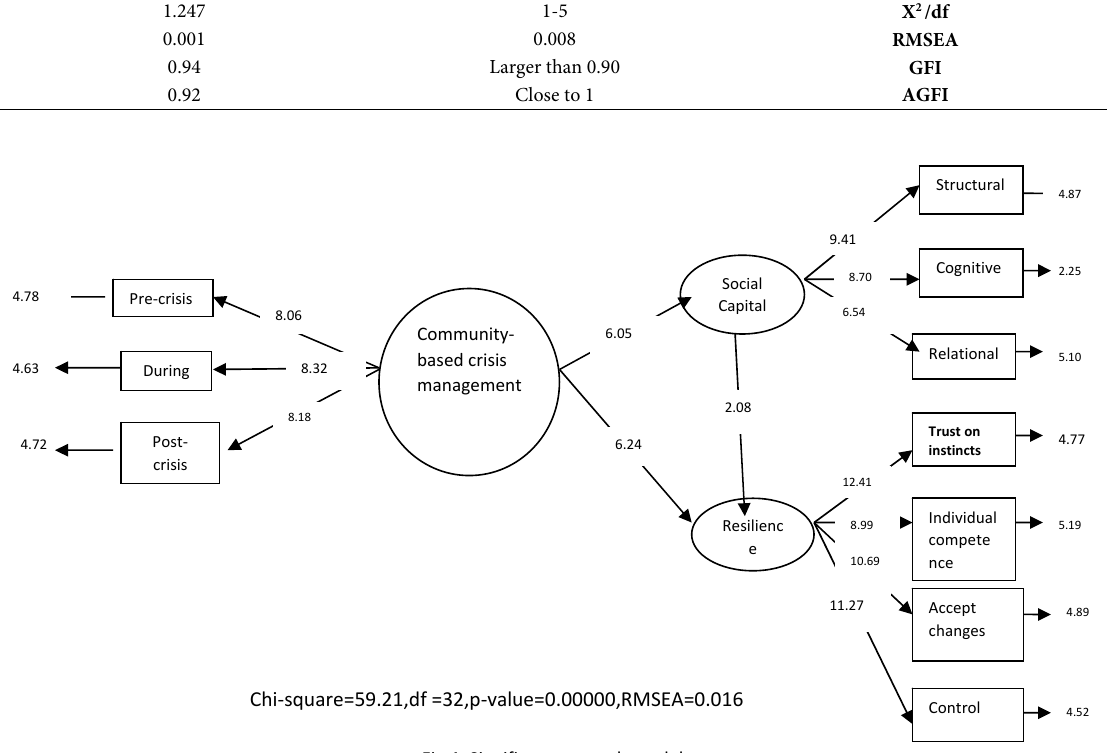
Fig 4: Significant research